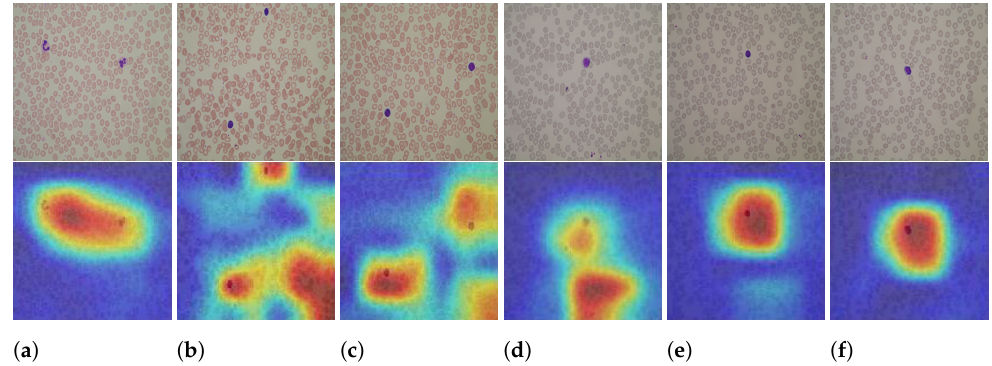
Figure 4. Visual Grad-CAM explanations for ResNet-50 exploited on the original test set images belonging to the healthy category. ( a ) Image n. 34 ( b ) Image n. 43 ( c ) Image n. 47 ( d ) Image n. 71 ( e ) Image n. 72 ( f ) Image n. 74.